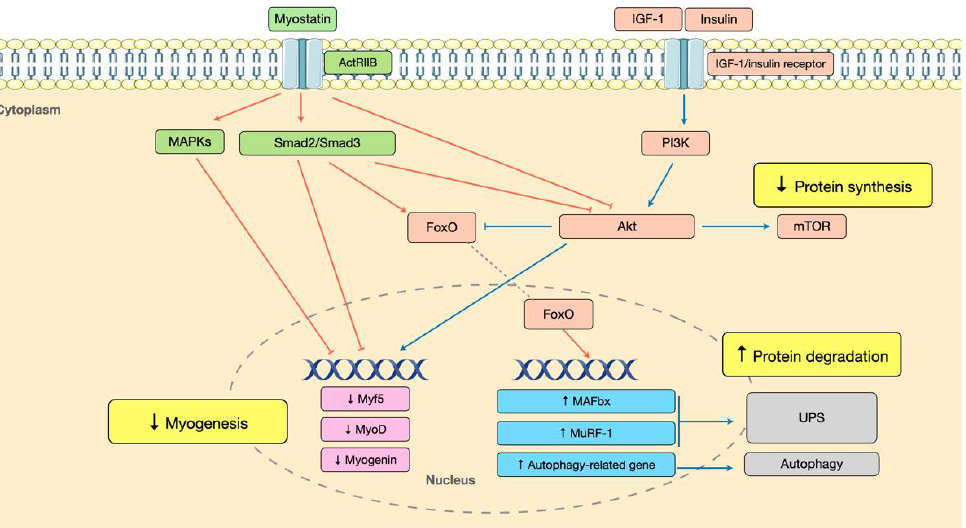
Figure 2. Altered cellular signaling pathways underlying muscle wasting in CKD. (Blue lines/arrows indicate activation; red lines/arrows indicate inactivation; upward arrows indicate upregulation or increase; downward arrows indicate downregulation or decrease.) The graphics used in this figure are adapted from Sevier Medical Art (www.smart.servier.com, accessed on 5 April 2022).